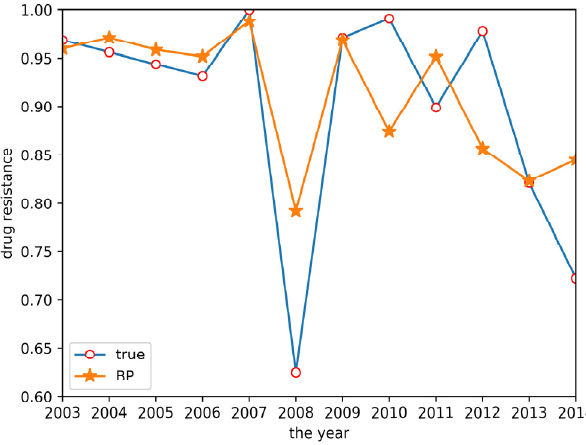
Figure 5. BP neural network prediction result.